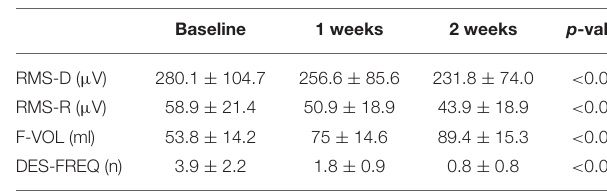
TABLE 2 | Changes in the electrical activity of respiratory muscles and feeding status.